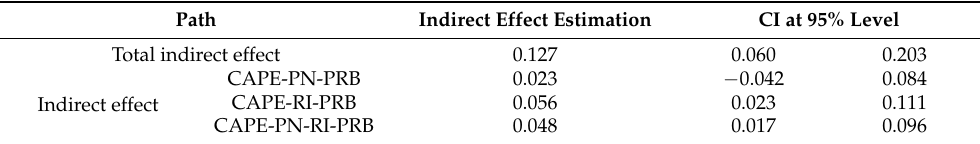
Table 3. Mediating effect and 95% confidence interval estimated by Bootstrap method.